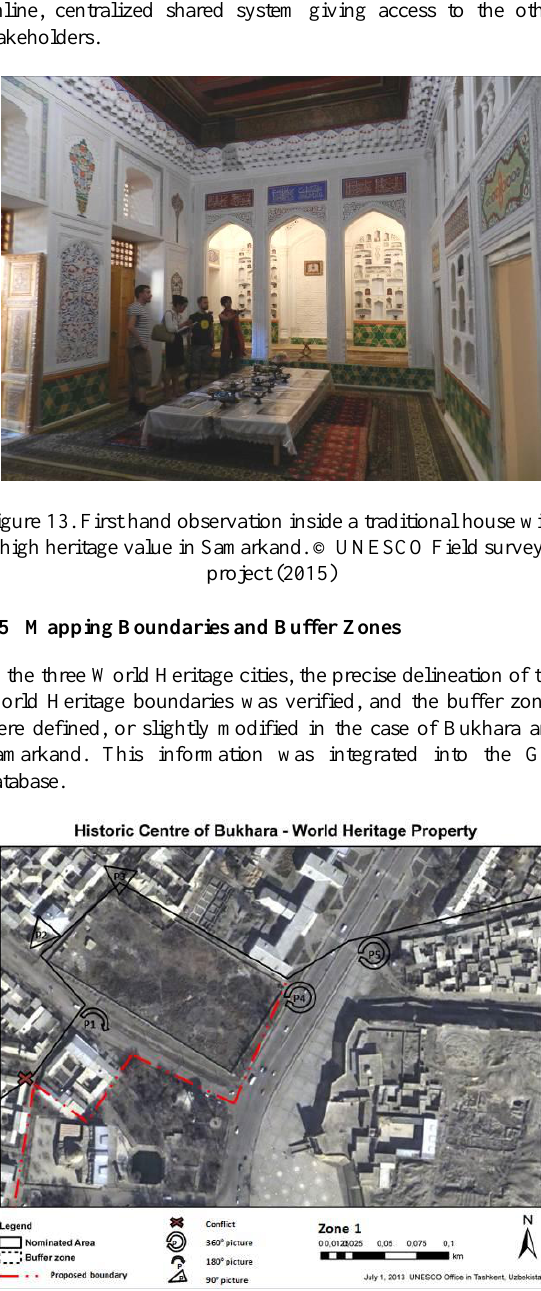
Figure 14. Example of boundaries verification in